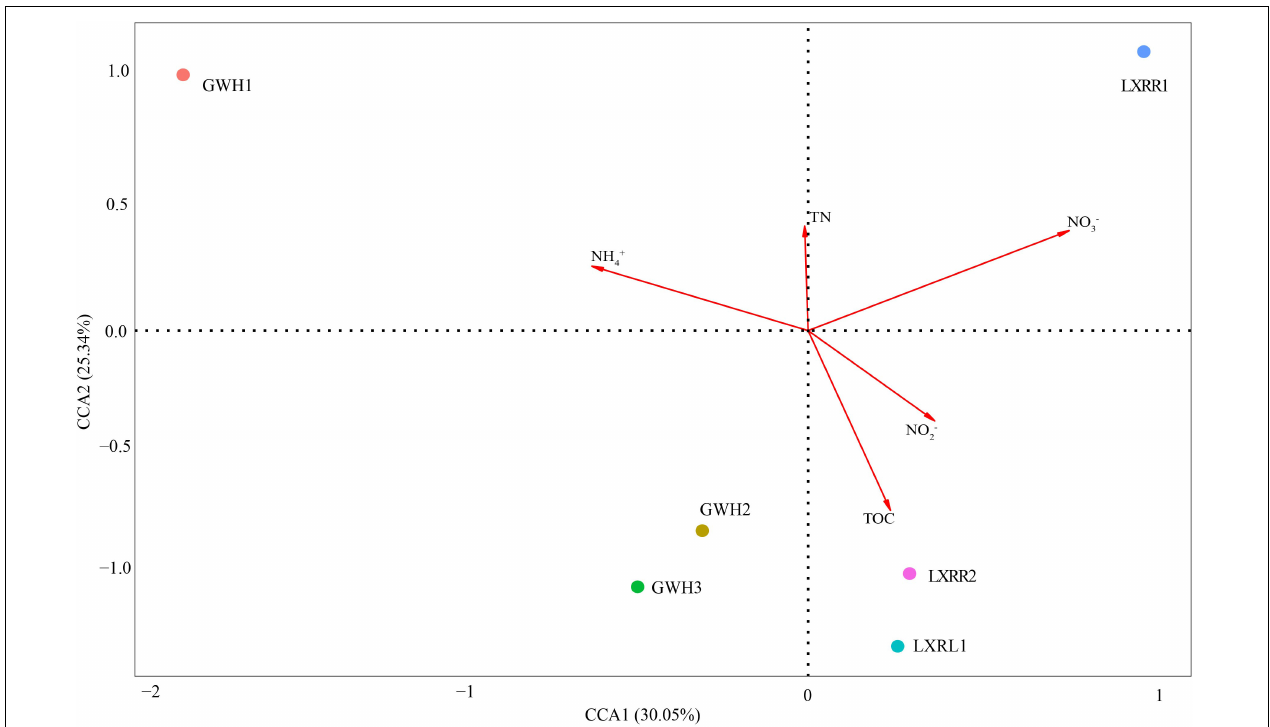
FIGURE 4 | Canonical correspondence analysis (CCA) ordination plots for the first two principal dimensions to show the relationship between anammox bacterial community composition and physicochemical parameters. The percentage indicates the interpretation of axis to the diversification of anammox bacterial community. Correlations between environmental variables and CCA axes are represented by the length and angle of arrows. Circles with different colors represent diverse samples. Arrow length expresses relative importance of an environmental variable; the longer the arrow, the greater influence of environmental factors. Dropping perpendicular to the arrows from each of the samples indicates the strength of the environmental factor’s influence on the sample; the shorter distance, the stronger the effect of the environmental factor on the sample. The sample is located in the same direction as the arrow, indicating that the environmental factor is positively correlated with the change of the bacterial community, and the sample is located in the opposite direction of the arrow, indicating that the environmental factor is negatively related to the change of the bacterial community. TOC and TN mean total organic carbon and total nitrogen,